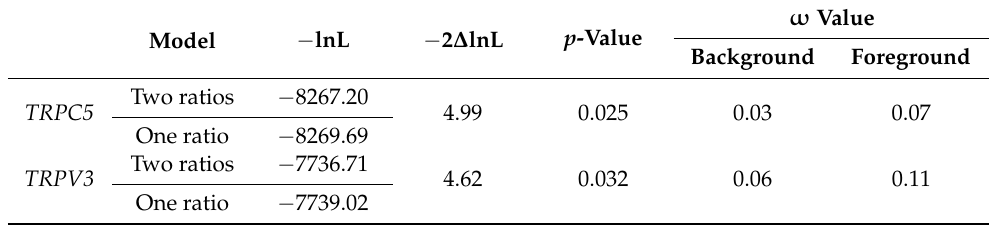
Table 2. Log likelihood and omega values estimated under the branch model of Gekko japonicus on TRP genes.